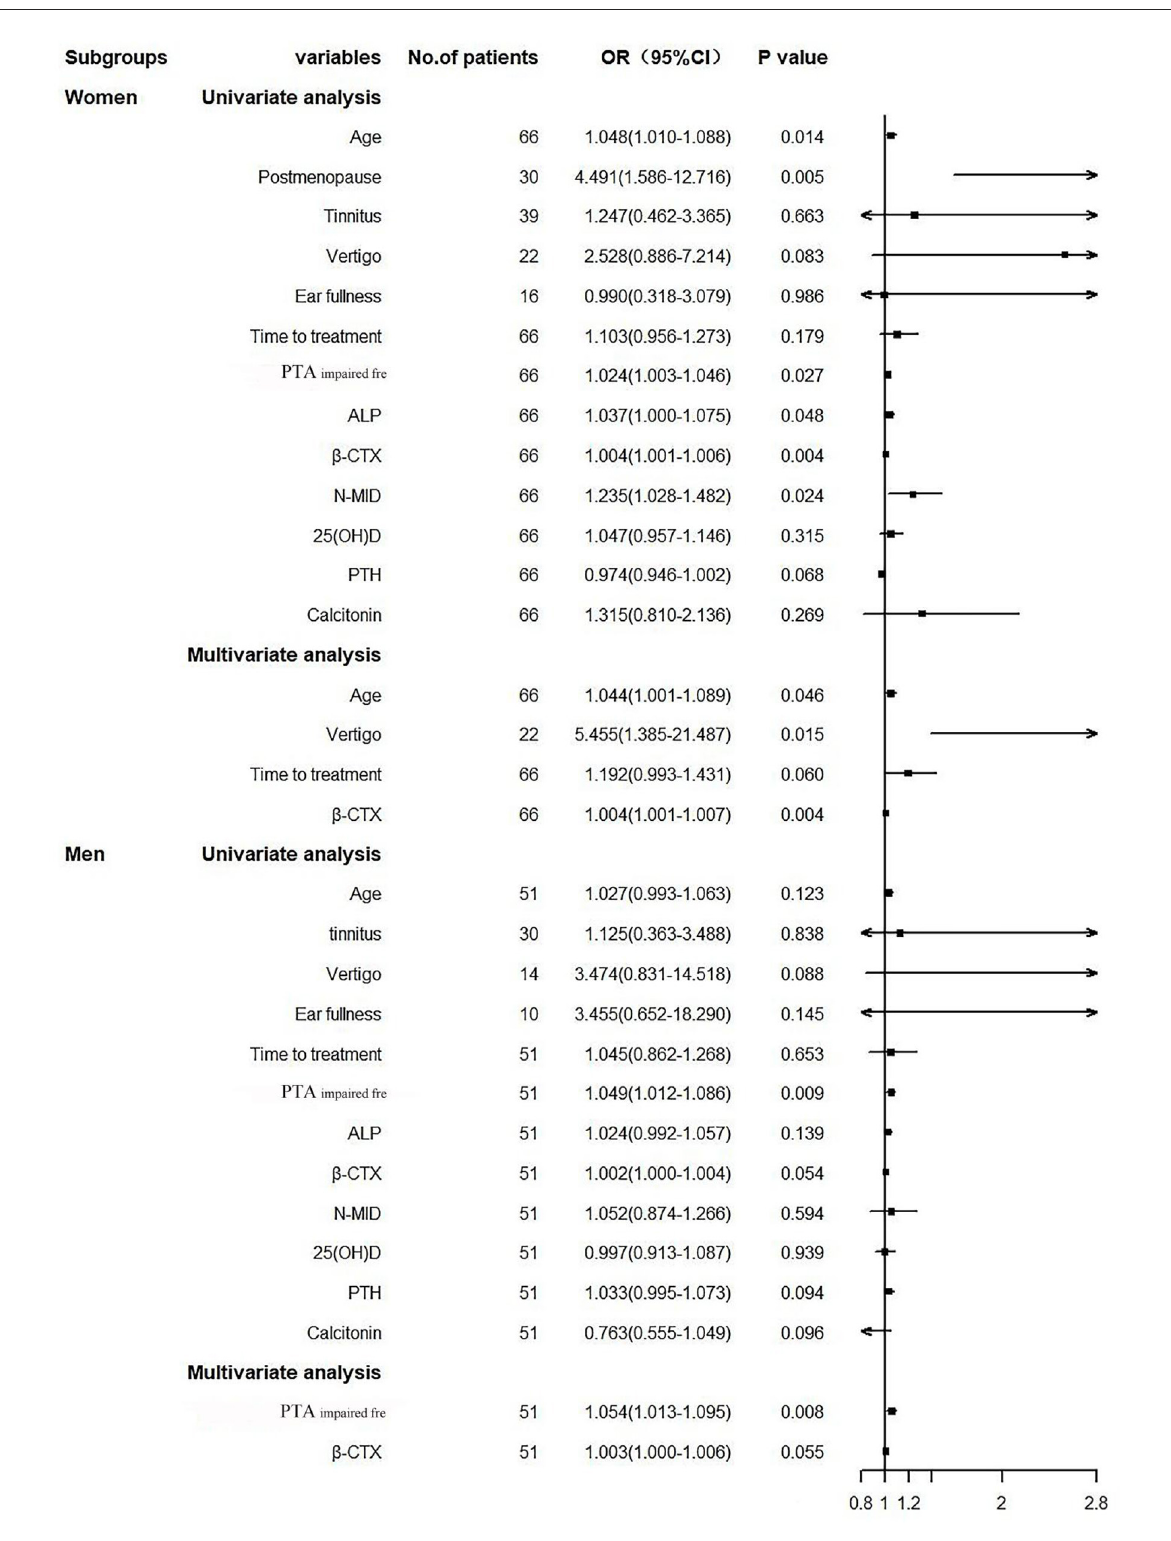
FIGURE3 Forest plot. PTA impairedfre, Pure tone average of the impaired frequencies (0.125–8kHZ); ALP, Alkaline phosphatase; β -CTX, β -carboxy terminal crosslinked telopeptide of type 1 collagen; N-MID, N-terminal-midfragment of osteocalcin; 25(OH)D, 25 hydroxyvitamin D; PTH, parathyroid